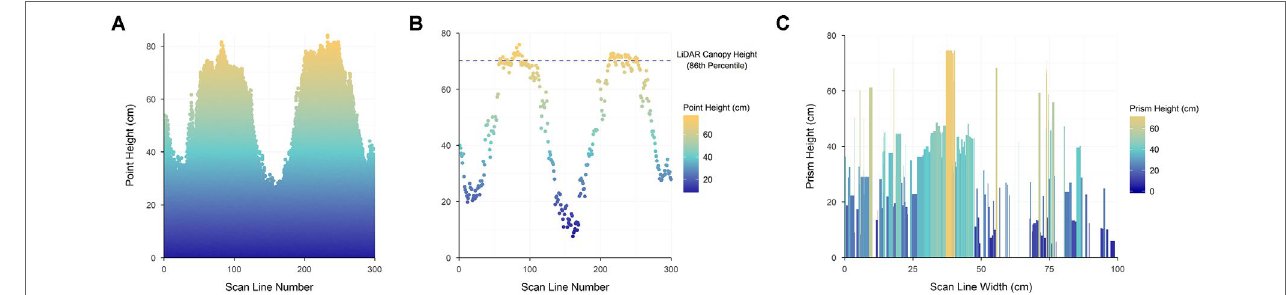
FIGURE 3 | The height of all laser returns present in each scan line of a point cloud segmented for processing (A) , a visualization of the LiDAR Canopy Height calculation process (B) showing the 98 th percentile of processed points within each scan line and the over-all LiDAR Canopy Height value, represented with a dashed blue line, as calculated by the 86 th percentile of these points, and a two-dimensional representation of LiDAR Projected Volume calculated for a single scan line of the point cloud (C) ; the width and height of each prism being represented by the x axis (scan line width) and the y axis (prism height) respectively. The depth of each prism is calculated from the distance between scan lines as the LiDAR sensor moves, producing the unplotted z axis (prism